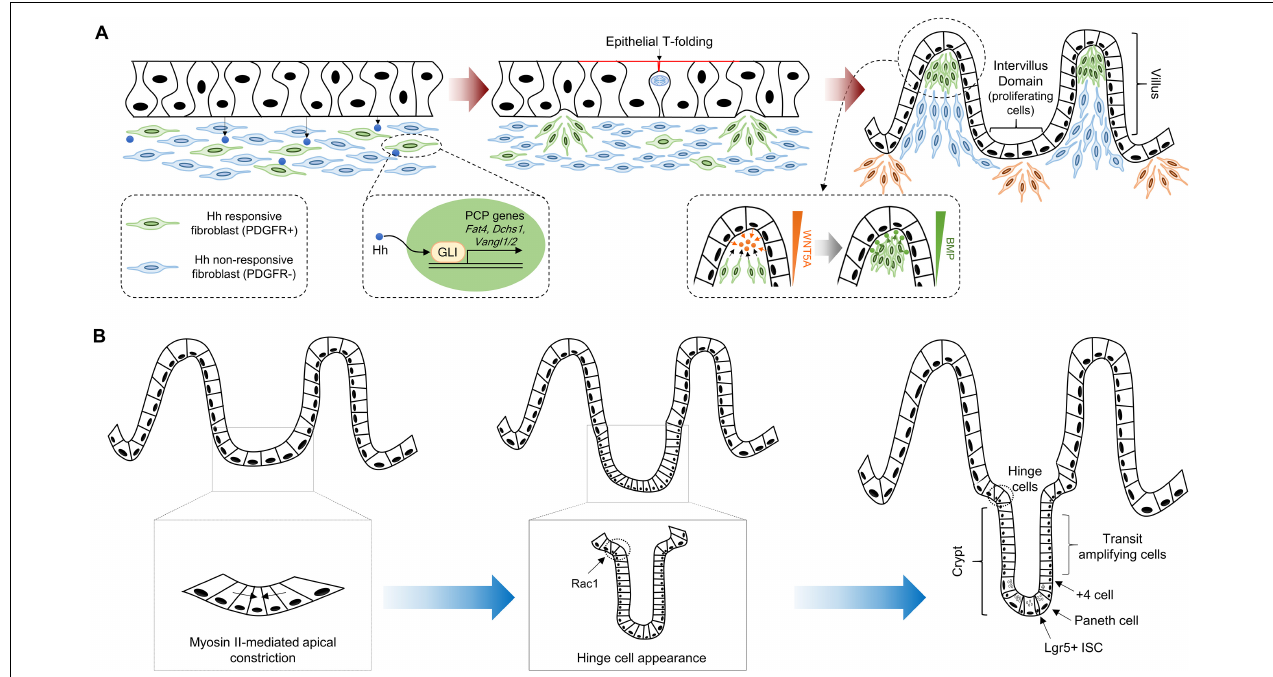
FIGURE 1 | Crypt-villus morphogenesis during mouse development. (A) The pseudostratified intestinal epithelium secretes Hh ligands that induce expression of PCP genes, such as Fat4 , Dchs1 , Vangl1 , and Vangl2 , via GLI transcriptional factor activation. Clustered mesenchymal cells (green color) cause deformation of intestinal epithelium through apical membrane invagination with the emergence of epithelial T-folding. The clustered mesenchymal cells underneath the tip of the villus, which are formed by directional migration toward chemoattractants such as WNT5A, enforce villification and differentiation of intestinal epithelium via secretion of soluble ligands including BMPs. New mesenchymal clusters (orange color) beneath the intervillus domain lead to the second round of villification processes. (B) Intervillus proliferating cells transform into crypts. The initiation of crypt formation is driven by myosin II-mediated apical constriction and invagination of the crypt cells. Subsequently, hinge formation in the crypt neck is initiated to compartmentalize crypts and villus, and Rac1 controls this process through the wedge-shaped hinge cell formation. These crypts contain Lgr5 + ISCs intercalated between Paneth cells at the crypt base, and transit amplifying